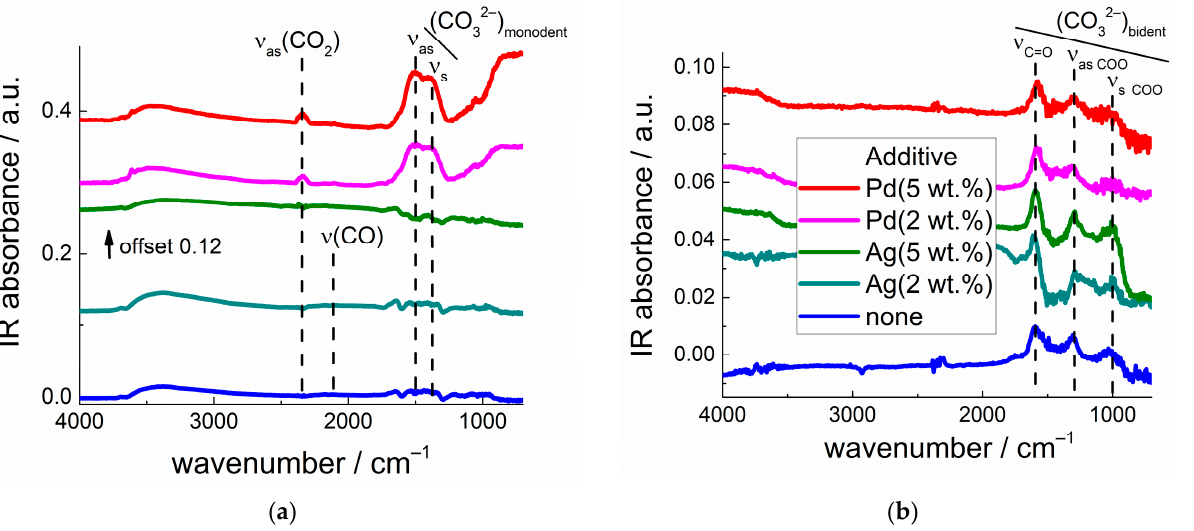
Figure 10. DRIFT spectra of pristine and Ag- or Pd-modified LaFeO 3 under exposure to 400 ppm CO for 1 h at room temperature ( a ) and at 200 °C ( b ).